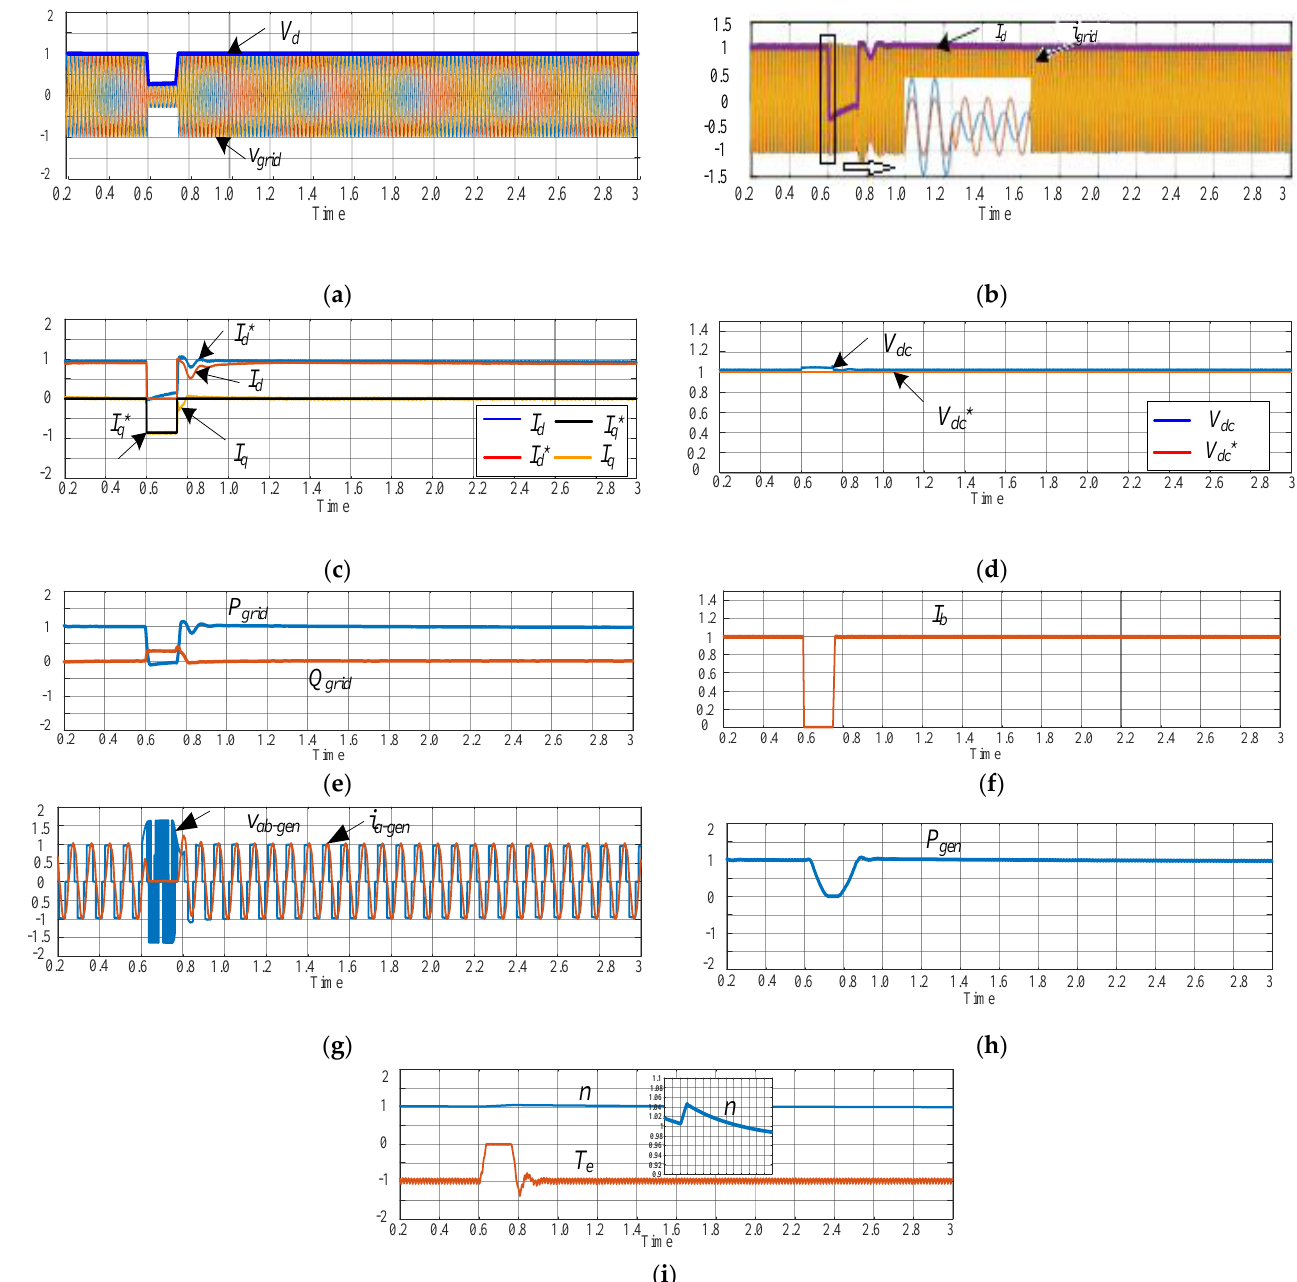
Figure 8. Simulation results during 70% symmetrical grid voltage dip with the proposed control scheme: ( a ) abc grid voltages v grid and d– axis grid voltage V d (p.u.); ( b ) abc grid currents i grid and d-axis grid current I d (p.u.); ( c ) d– axis currents I d and reference I ∗ with q– axis currents I q and d reference I ∗ q ; ( d ) DC– link voltage V dc and reference V ∗ (p.u); ( e ) grid active power P grid and reactive dc power Q grid (p.u); ( f ) boost chopper current I b and reference I ∗ (p.u) ( g ) PMSG Line-line voltage b v ab – gen and phase a-current i a − gen ; ( h ) PMSG active power P gen (p.u); ( i ) PMSG speed n and torque T e